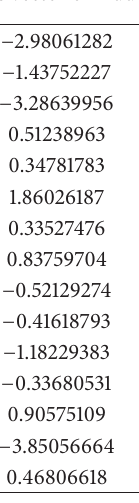
Table 9: Bias vector of output layer ( 𝜃 𝑜